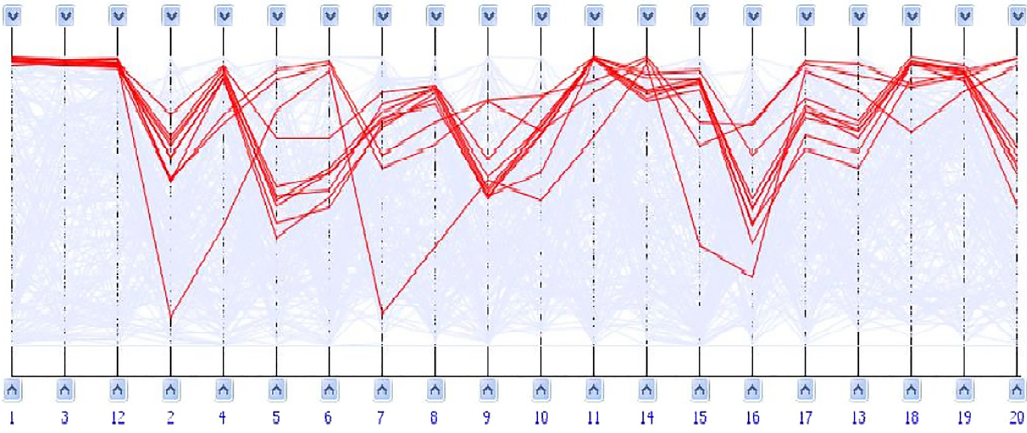
Figure 9: Parallel coordinates visualization. Polylines of interesting genes colored in red [31].